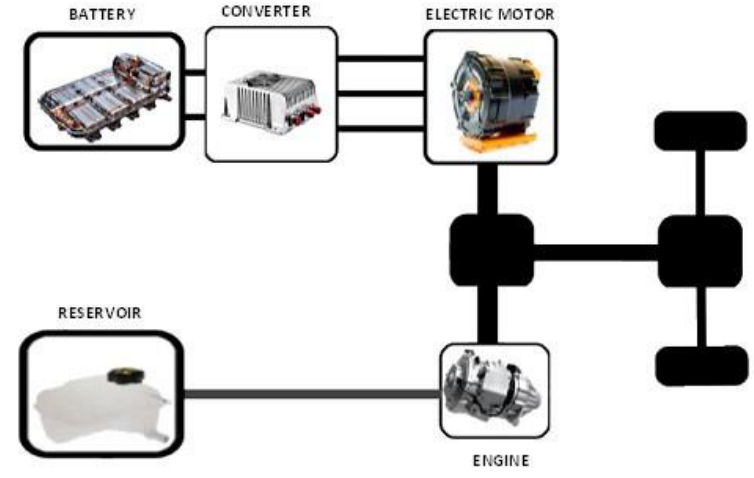
Figure 2. Schematic of parallel hybrid electric vehicles (PHEV).